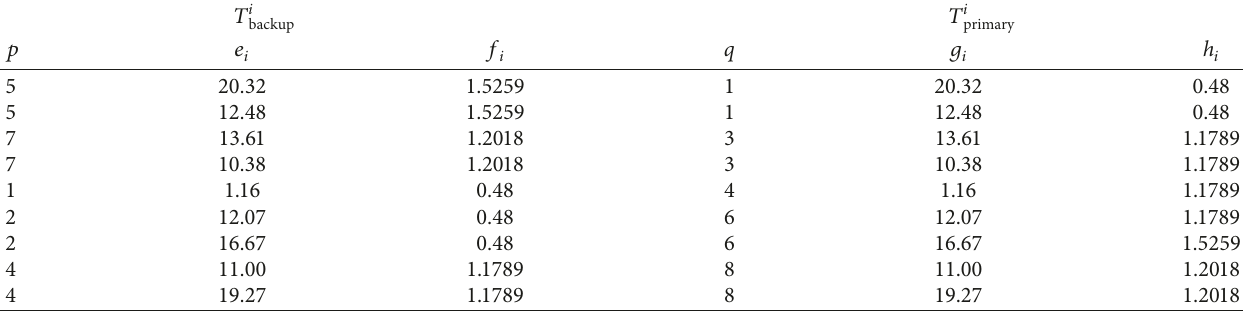
f g h i , i , i , and i for the 4-bus system [5, 9].